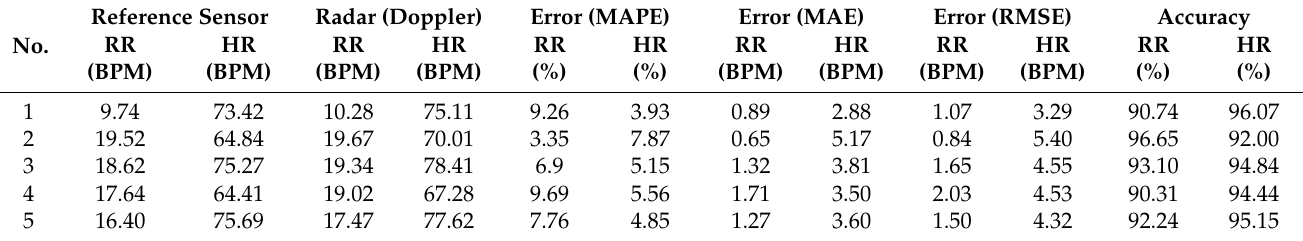
Table 4. The measurement accuracy of respiration and heartrates monitored by the FMCW radar with beamforming for the case without interferer.